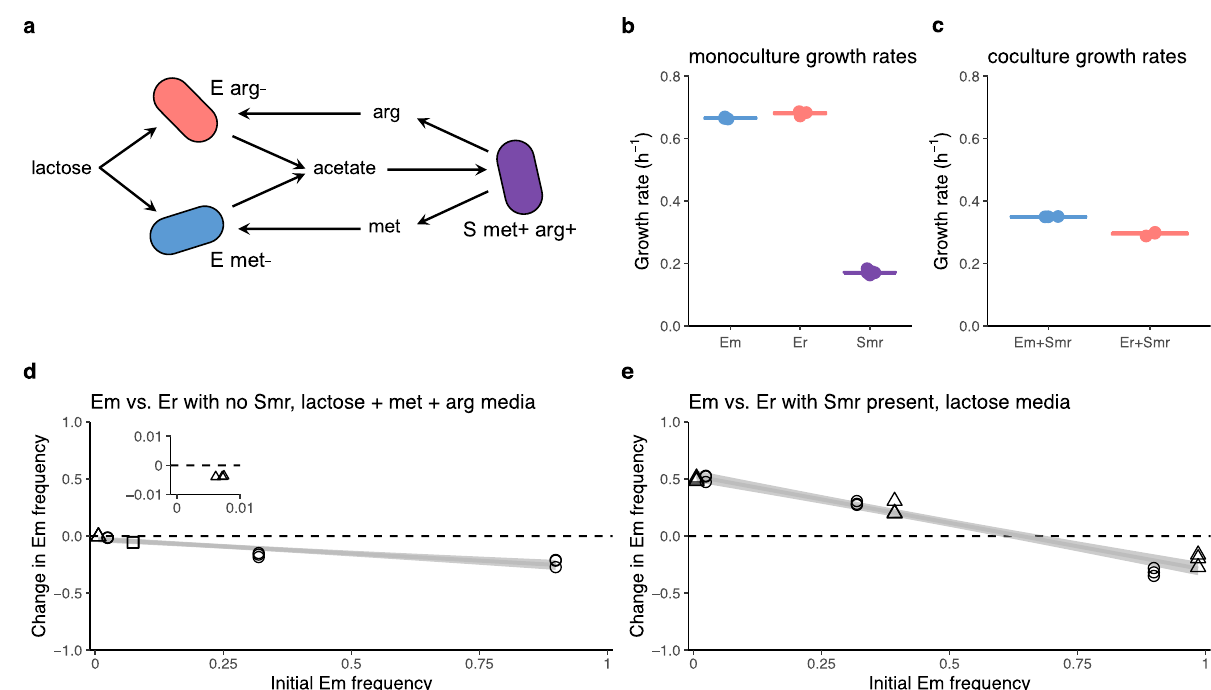
Fig. 2 Laboratory results show the coexistence of competing partner strains in a multiple mutualist community. a Schematic showing the interactions between the E. coli partner mutualists that comprise the partner guild and the S. enterica shared mutualist. The arginine auxotroph, E arg − ( “ Er ” ), and the methionine auxotroph, E met − ( “ Em ” ), consume lactose and produce acetate. S met + arg + ( “ Smr ” ) consumes acetate and produces both arginine (arg) and methionine (met). b The growth rates in monoculture of the three strains differ (one-way ANOVA: F (2, 9) = 9897, P = 9.1e-16). Er grows faster than Em (Tukey HSD: P = 0.037), and Smr grows much more slowly than either E. coli strain (Tukey HSD: P < 1e-7). Em ( n = 3) and Er ( n = 3) were grown in lactose media with excess methionine and arginine, and Smr ( n = 6) was grown in acetate media. All data points are shown, and the horizontal lines show means. Replicates were independent biological replicates performed over one experiment. c Growth rates of Em + Smr ( n = 3) and Er + Smr ( n = 3) cocultures. Em + Smr cultures grow faster (Welch ’ s two-sample t test: t (2) = 15, P = 0.004). All data points are shown, and the horizontal line shows the mean. Replicates were independent biological replicates performed over one experiment. d A mutual invasibility experiment with cocultures of Em and Er in a lactose medium with excess amino acids. The frequency of Em decreases from all starting frequencies, including when started at 0.6% of the population (inset plot; Welch ’ s two-sample t test: t (2) = 48, P = 0.0004), indicating that Em is the weaker competitor for lactose. The change in Em frequency was calculated as [Em/(Em + Er)] fi nal − [Em/(Em + Er)] initial . Supplementary Fig. 4 shows that Em frequency also decreases when Smr is present in this environment. e A mutual invasibility experiment in the three-strain multiple mutualist community in a lactose medium. Em increases in frequency when started rare (Welch ’ s two-sample t test: t (2) = − 58, P = 0.0003), but decreases in frequency when started common (Welch ’ s two-sample t test: t (2) = 6, P = 0.02), indicating that the two E. coli strains coexist. The change in Em frequency was calculated as [Em/(Em + Er)] fi − [Em/(Em + Er)] nal initial . Smr yields are similar across all Em frequencies (Supplementary Fig. 7). In panels d and e , shapes indicate independent experimental batches (A = circles, B = triangles, C = squares). Sample sizes, means, and standard deviations are given in “ Results ” . Source data are provided as a Source Data fi